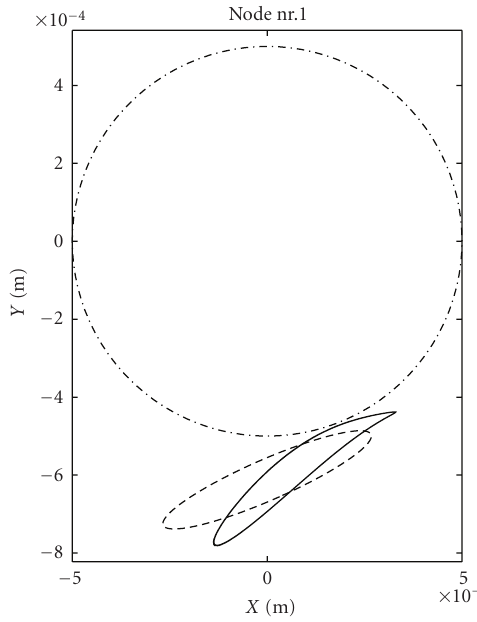
Figure 8: Displacement orbits in